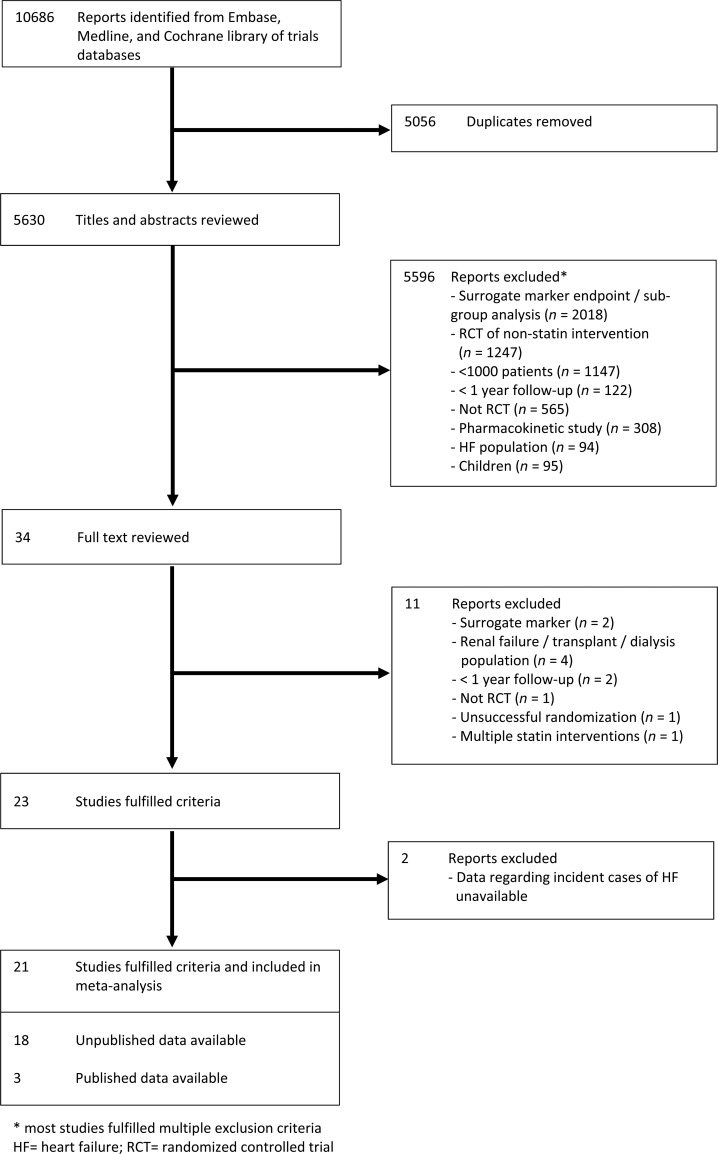
Flow diagram of literature search to identify randomized placebo-controlled trials, standard care-controlled trials, and dose-comparison statin trials.